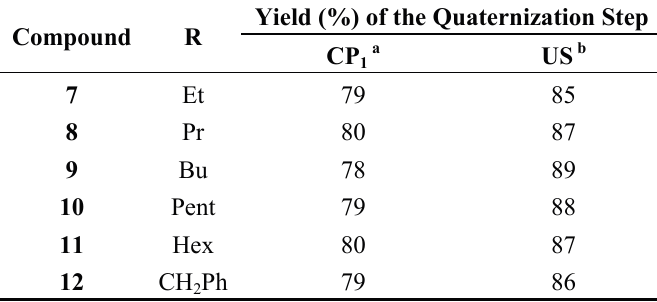
Table 1. Reaction conditions and yields for the quaternization of N-alkylimidazole ( 7 – 12 ) using conventional preparation (CP) and ultrasound irradiation conditions (US).